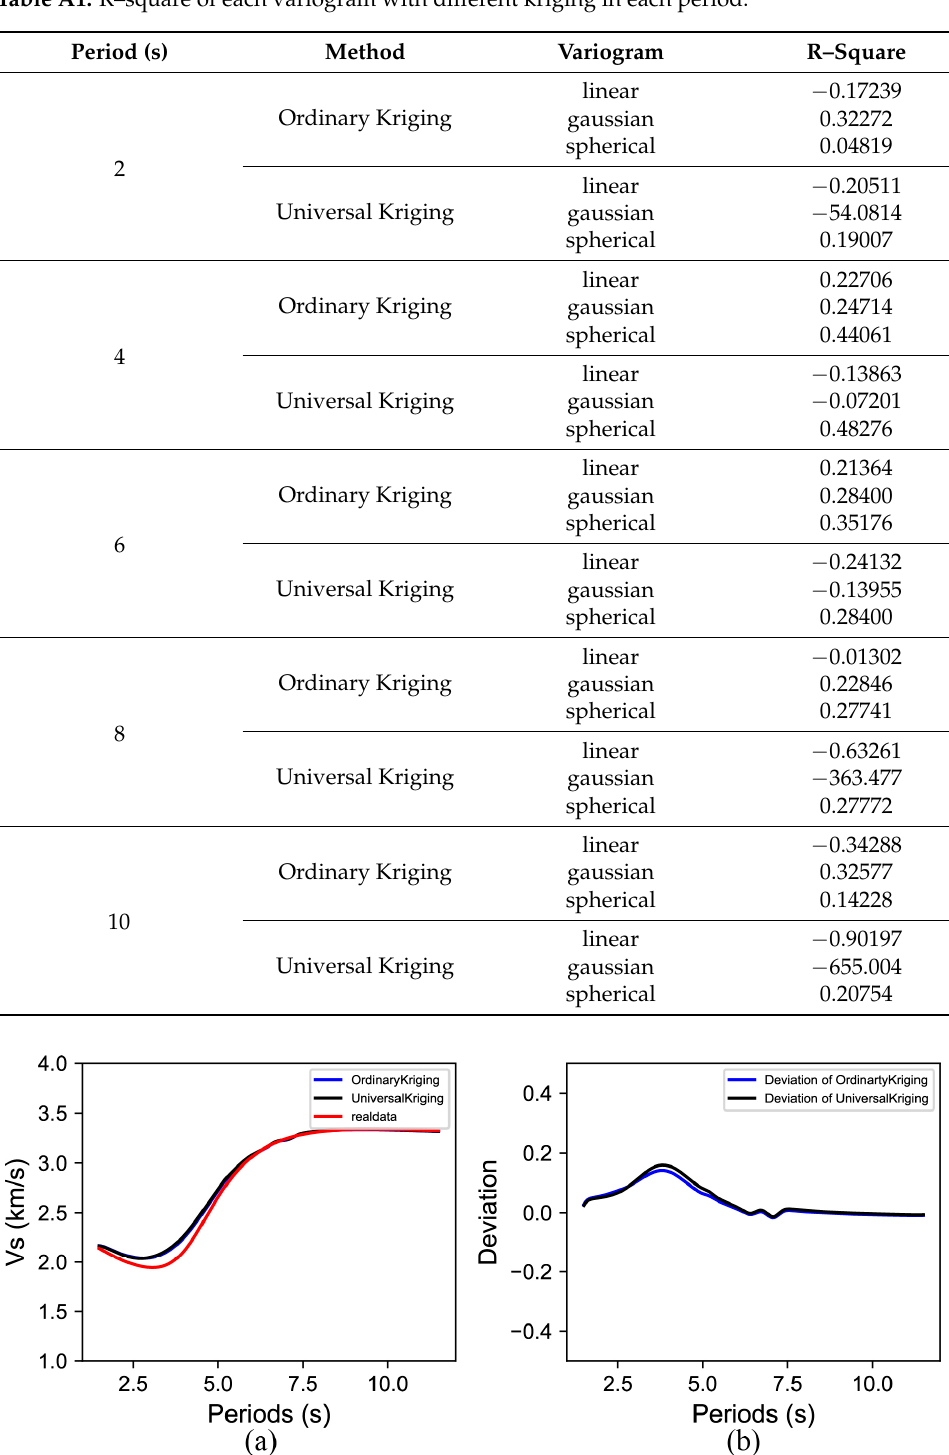
Figure A1. Comparison of dispersion curve interpolation results (127.76° E, 42.06° N ). The blue curve indicates the ordinary kriging results, while the black curve indicates those of universal kriging: ( a ) Comparison of dispersion curves; and ( b ) deviation of the OK (blue) or UK (black) results.